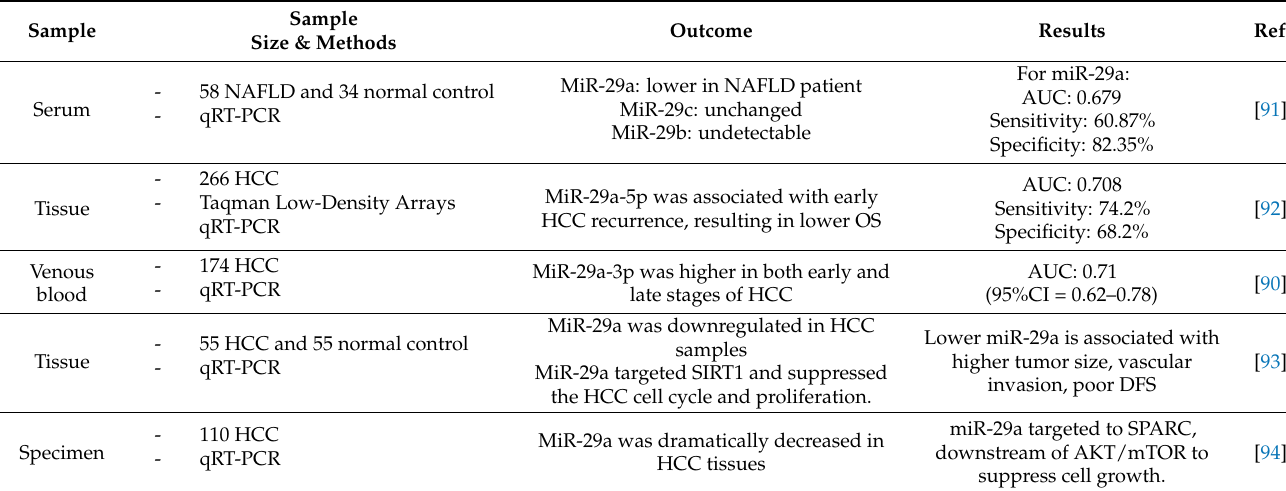
Table 3. MiR-29s as biomarkers in hepatocellular